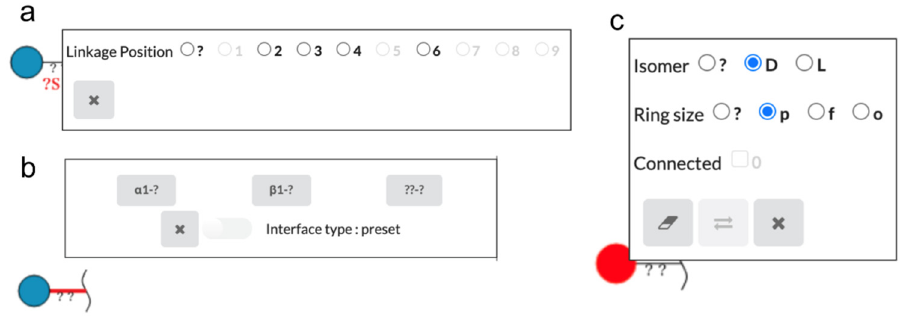
Figure 2. Pop-up windows for editing monosaccharides, substituents, and linkages between them: ( a ) the window to select possible linkage positions is displayed when the substituent is clicked; ( b ) the window to select combinations of possible anomer and linkage positions is displayed by clicking on the glycosidic linkage; ( c ) the window to edit the monosaccharide is displayed by right-clicking on the monosaccharide. This contains selections for stereo configurations (Isomer), ring sizes and attachment sites, as well as buttons to delete and replace the selected monosaccharide.